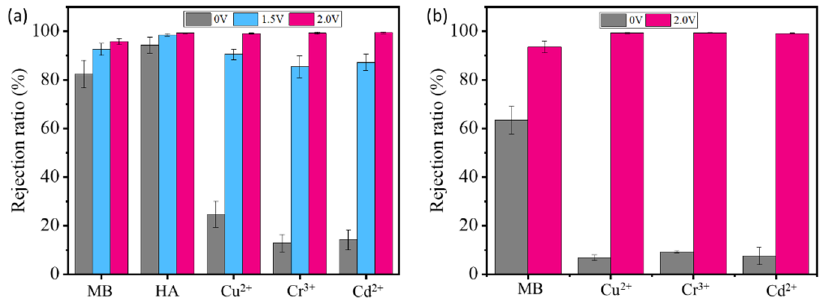
Figure 5. ( a ) Rejection ratios of various targets by SrGO membranes at different voltages during filtration of corresponding solutions; ( b ) Rejection ratios of various targets by SrGO membranes at 0 V and 2.0 V during filtration of their mixed solution.